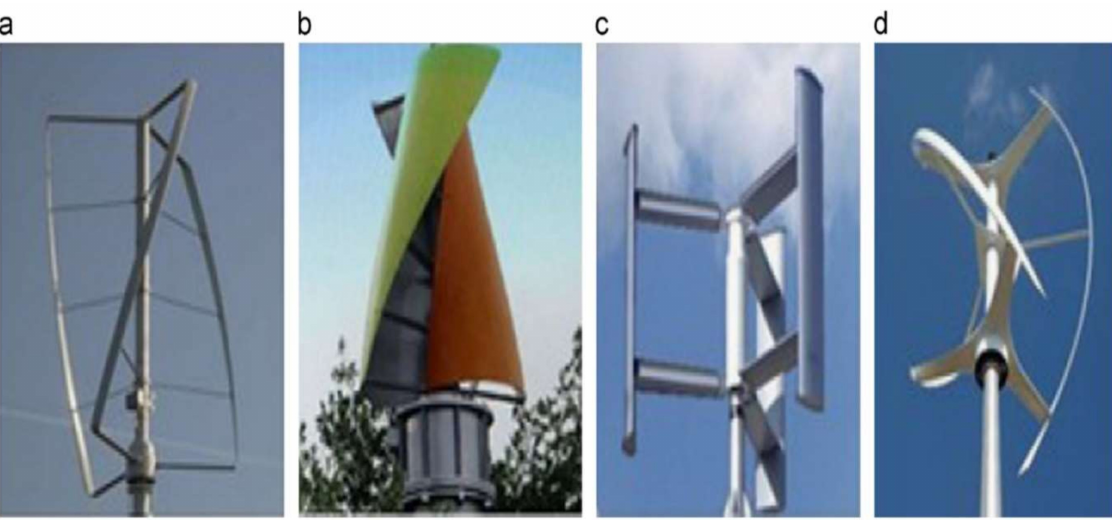
Figure 11. Types of Darrieus turbine blades: ( a ) Turby; ( b ) Windside; ( c ) Ropatec; ( d ) Gorlov helical